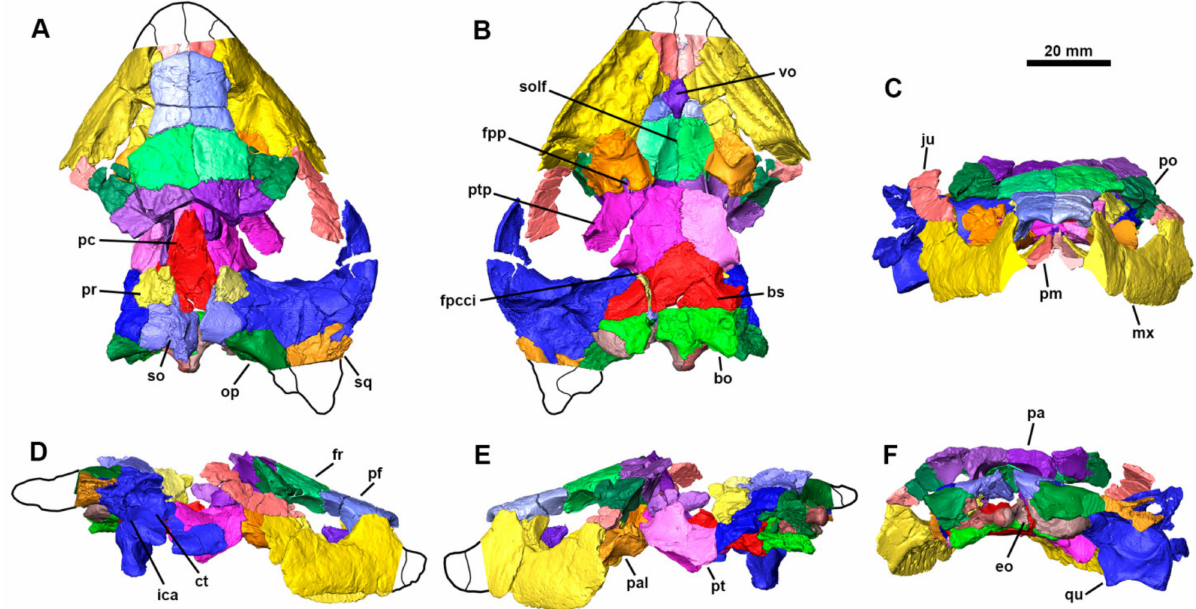
Figure 2. Virtual three-dimensional reconstruction of the specimen MNHN.F.SPP33, the holotype of Tartaruscola teodorii (Bothremydidae, Foxemydina), from the lower Ypresian (early Eocene) of Saint-Papoul (Aude, France), in which each bone is shown with a different color. The skull is presented in dorsal ( A ), ventral, ( B ), anterior ( C ), right lateral ( D ), left lateral ( E ) and posterior ( F ) views. Abbreviations: bo, basioccipital; bs, basisphenoid; ct, cavum tympani; eo, exoccipital; fpcci, foramen posterius canalis caroticum internus; fpp, foramen palatinum posterius; fr, frontal; ica, incisura collumela auris; ju, jugal; mx, maxilla; op, opisthotic; pa, parietal; pal, palatine; pc, processus clinoideus; pf, prefrontal; pm, premaxilla; po, postorbital; pr, prootic; pt, pterygoid; ptp, processus trochlearis pterygoideus; qu, quadrate; so, supraoccipital; solf, sulcus olfactorius; sq, squamosal; vo,